Question: Produce a descriptive caption suitable for publication.
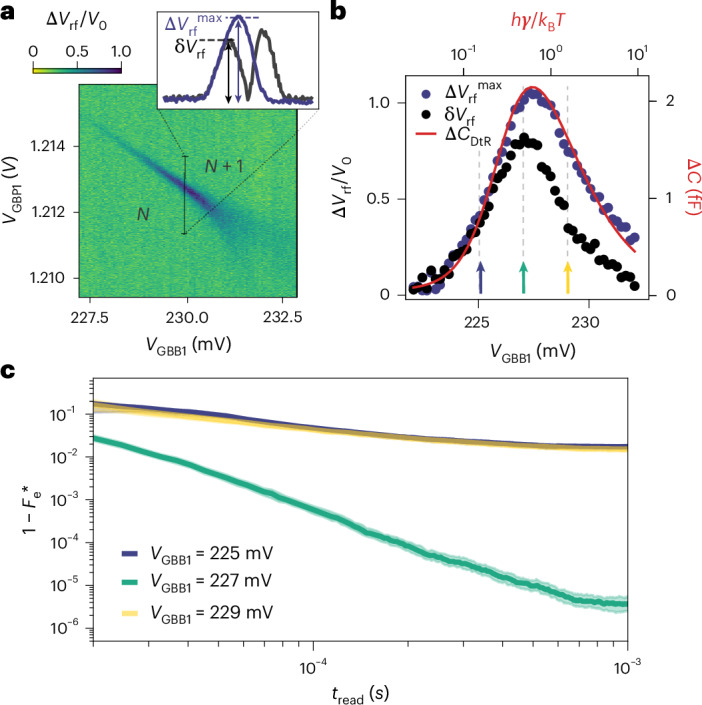
Answer: Tuning charge-readout fidelity via the SEB barrier gate. a , Stability diagram of the sensor with the plunger BP1 and barrier gate BB1, showing broadening of the peak at large V GBB1 from the enhanced lifetime. The peak separates regions of different electron numbers N and N + 1, where N ≃ 15. This map is taken at lower power than the rest of the panels to highlight the effect of lifetime broadening, explaining the apparent shift in optimal BB1 voltage (Supplementary Note D ). The inset shows the SEB peaks from Fig. 1c , where we define \documentclass[12pt]{minimal} \usepackage{amsmath} \usepackage{wasysym} \usepackage{amsfonts} \usepackage{amssymb} \usepackage{amsbsy} \usepackage{mathrsfs} \usepackage{upgreek} \setlength{\oddsidemargin}{-69pt} \begin{document}$$\Delta {V}_{{\rm{rf}}}^{max}$$\end{document} Δ V rf max as the height of the SEB peak (purple) and δ V rf as the contrast between the two charge states (black). b , Lifetime broadening of the SEB peak (black-labelled axes), showing the SEB peak height is reduced at γ larger than k B T . We superimpose a plot of Δ C DRT as a function of tunnel rate calculated from equation ( 2 ) (red-labelled axes), with f rf = 576 MHz, the lever arm and electron temperature from Supplementary Note D , and tunnel rate γ ranging from 0.05 to 19 GHz, assuming V GBP1 exponentially modulates tunnel rate γ . c , Electrical fidelity for three different SEB barrier gate voltages, indicated by arrows in b . The electrical fidelity is calculated using the threshold method and bimodal fitting. The optimal point (green) corresponds to γ = 1.1 GHz. The yellow point is in the lifetime-broadened regime, and the purple point is in the slow-tunnelling regime. In c , the error bands (when visible) approximate to ±1 σ from the fit ( Methods ).